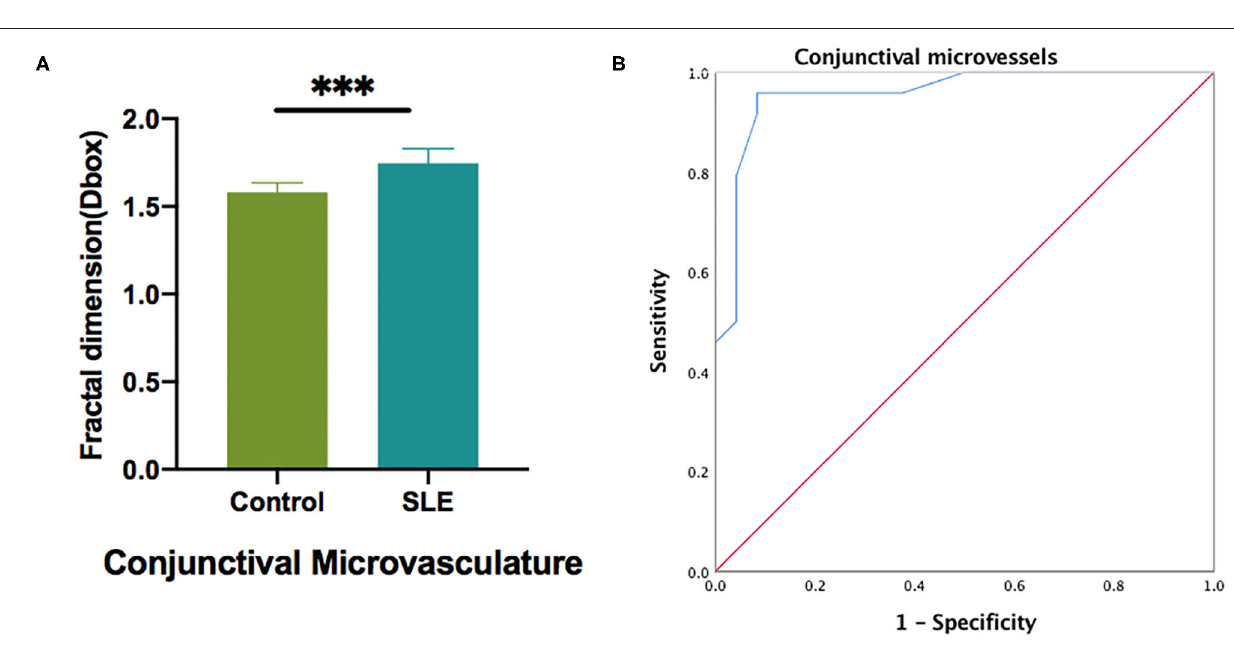
of ocular diseases. Currently, conjunctival microcirculation has been used to evaluate a variety of systemic diseases such as sickle cell disease (30), Alzheimer’s disease (31),